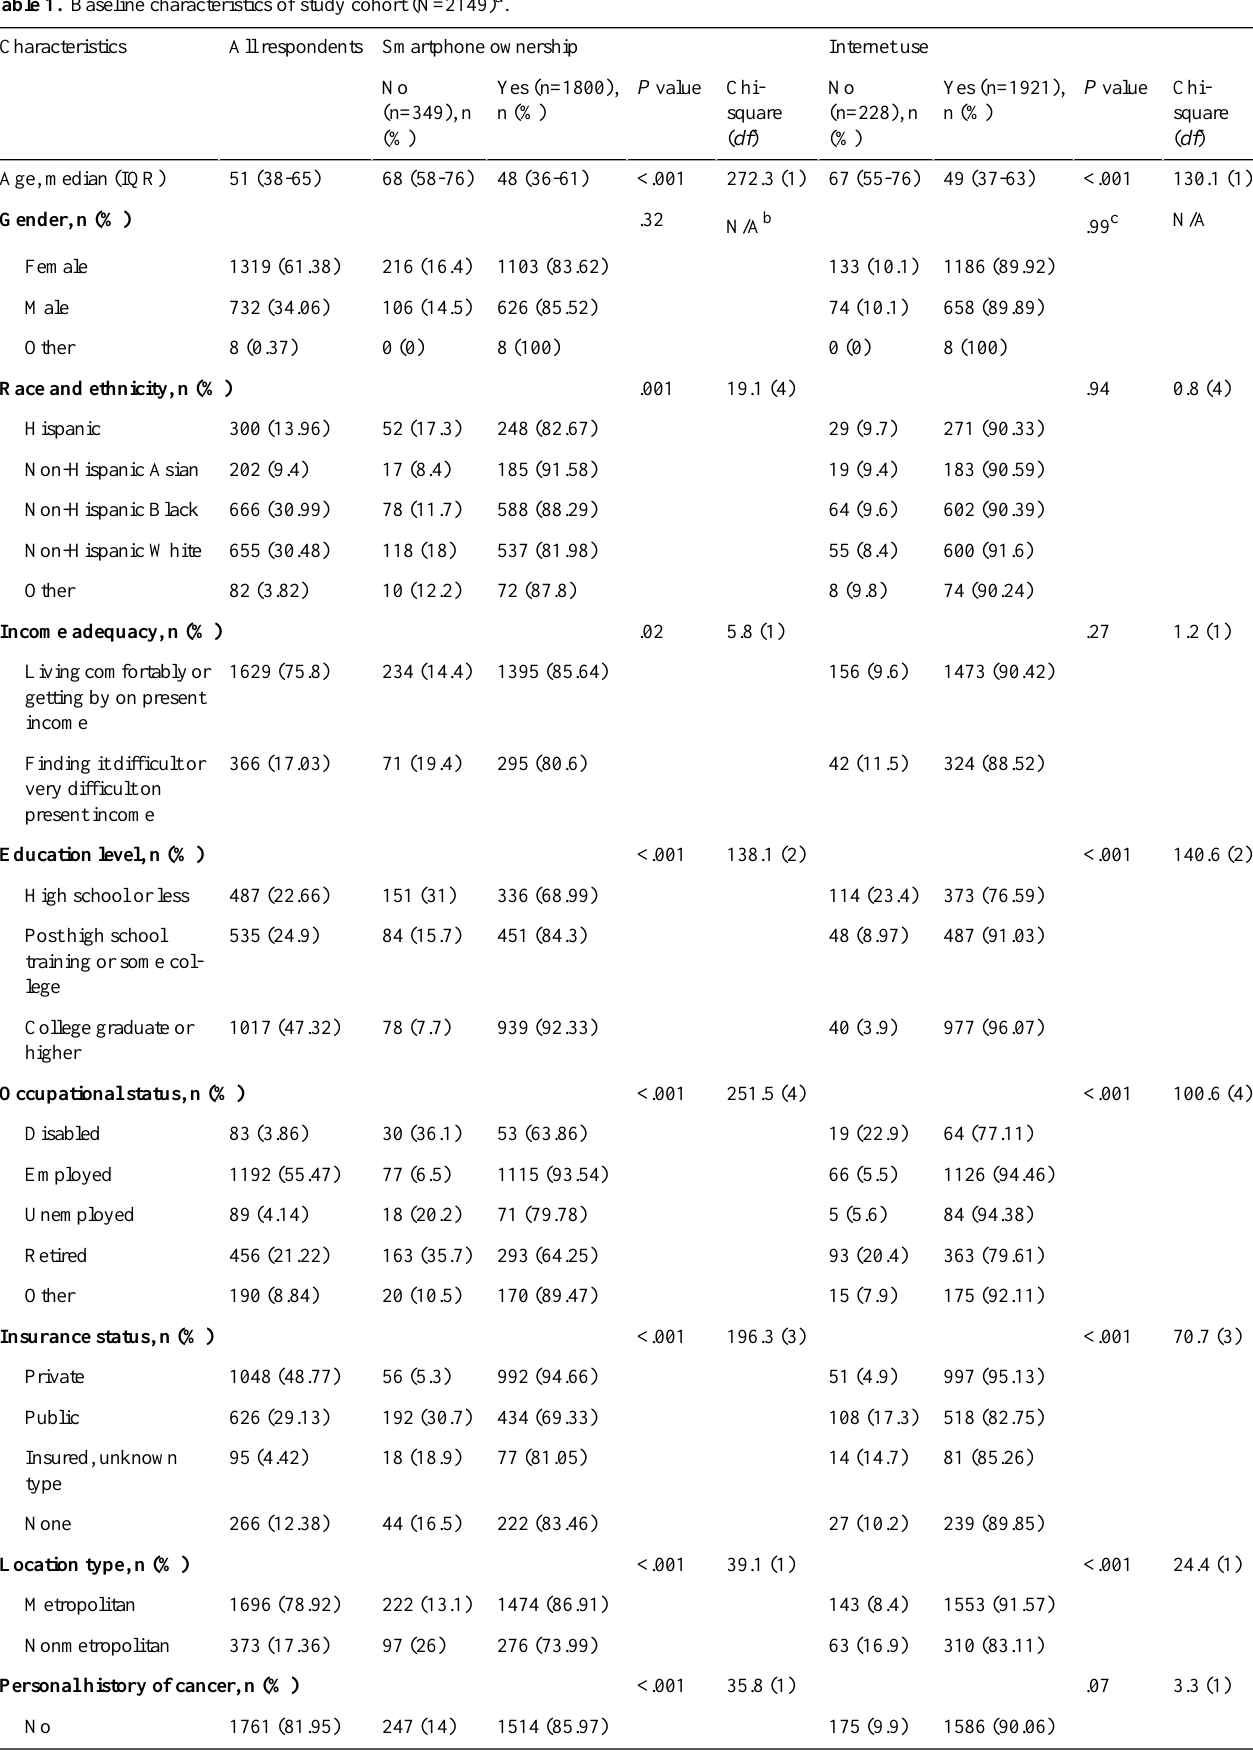
Table 1. Baseline characteristics of study cohort (N=2149) a .